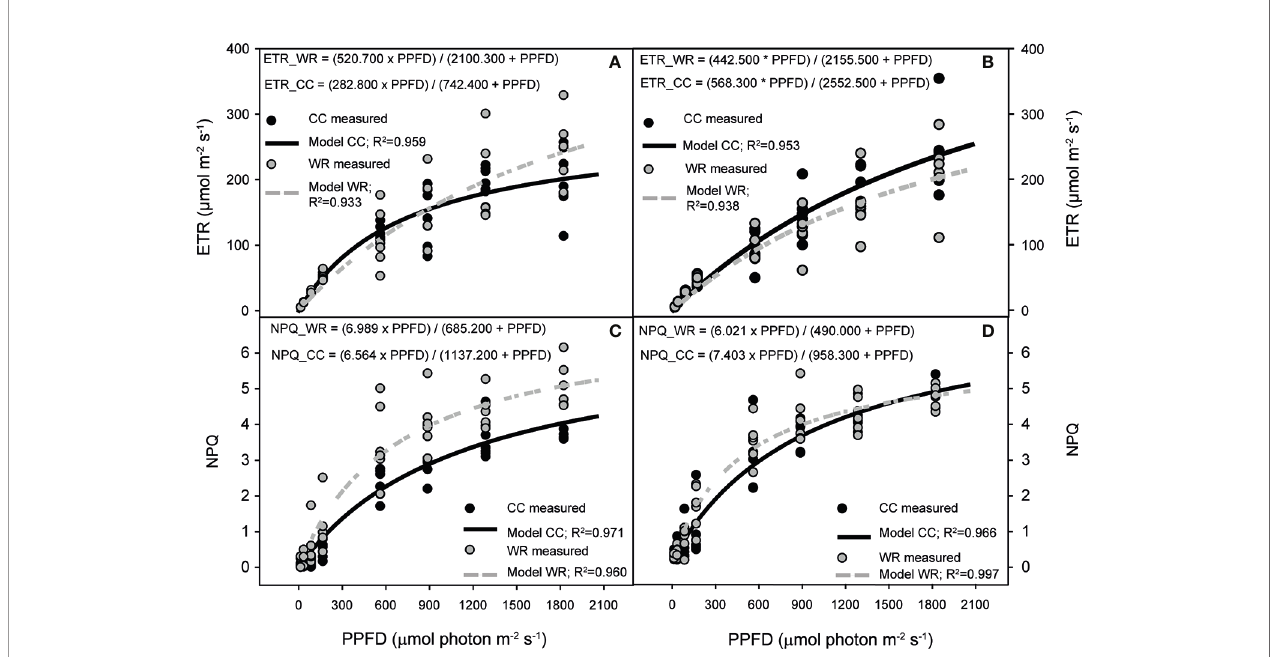
FIGURE 4 | Effect of increasing photosynthetic photon fl ux density (PPFD, µmol photon m -2 s -1 ) on electron transport rate (ETR, µmol m -2 s -1 ) (A , B) and non- photochemical quenching (NPQ) (C, D) of Cryptocarya alba plants from Santiago (A) , Nacimiento (B, D) and Cayumanque (C) under the water restriction (WR) and container capacity (CC) treatments. Dots indicate measured data (CC in black, WR in gray) and lines indicate modelled data (CC in continuous black line, WR in dashed gray line). Adjusted model for CC and WR treatments for each variable and population are shown on each